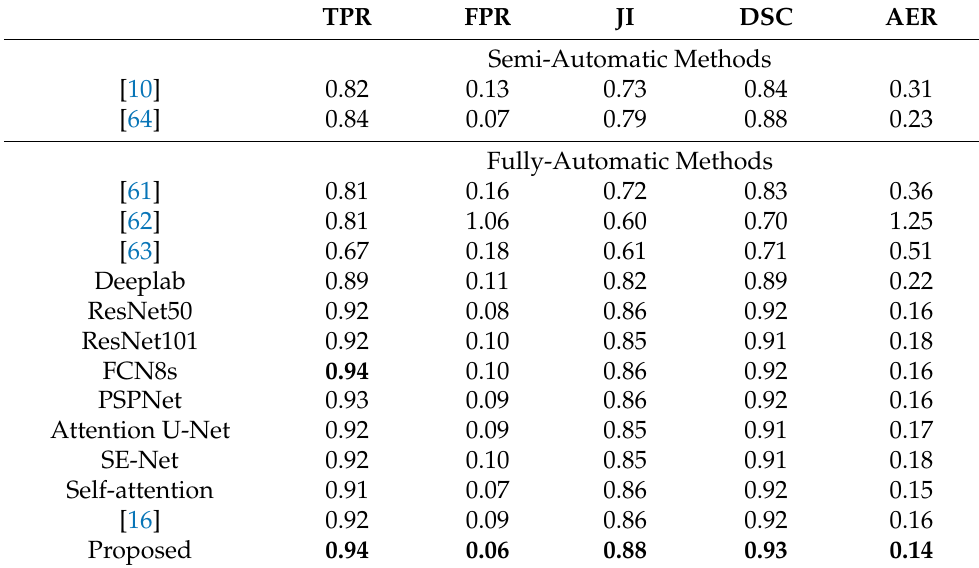
Table 4. Results of Two-class Semantic Segmentation on Dataset